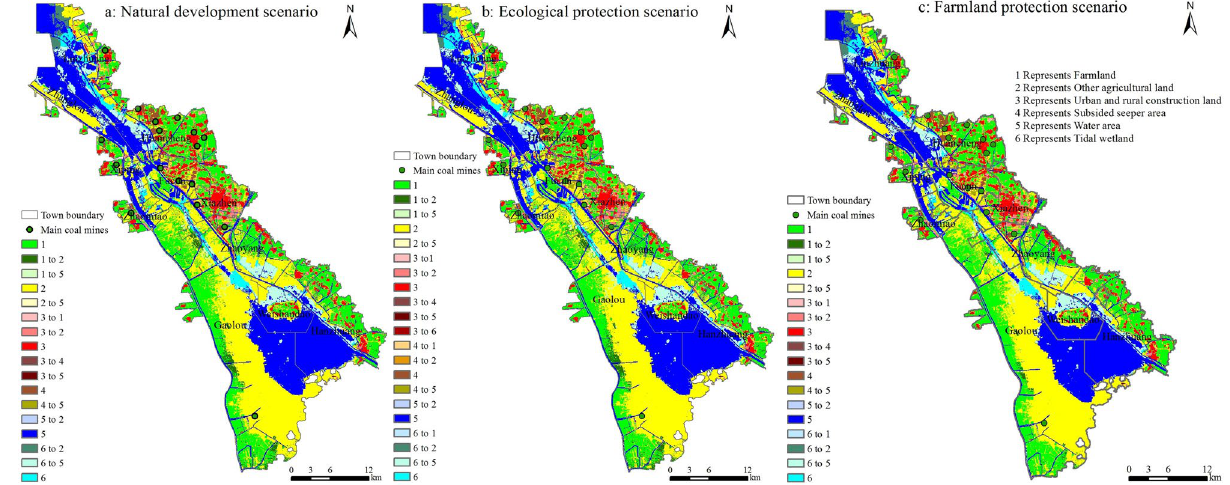
Figure 6. LULC changes under different scenarios from 2017 to 2025. Maps were generated using ArcGIS 10.1 for Desktop (http:// www. esri. com/ softw are/ arcgis/ arcgis- for- deskt